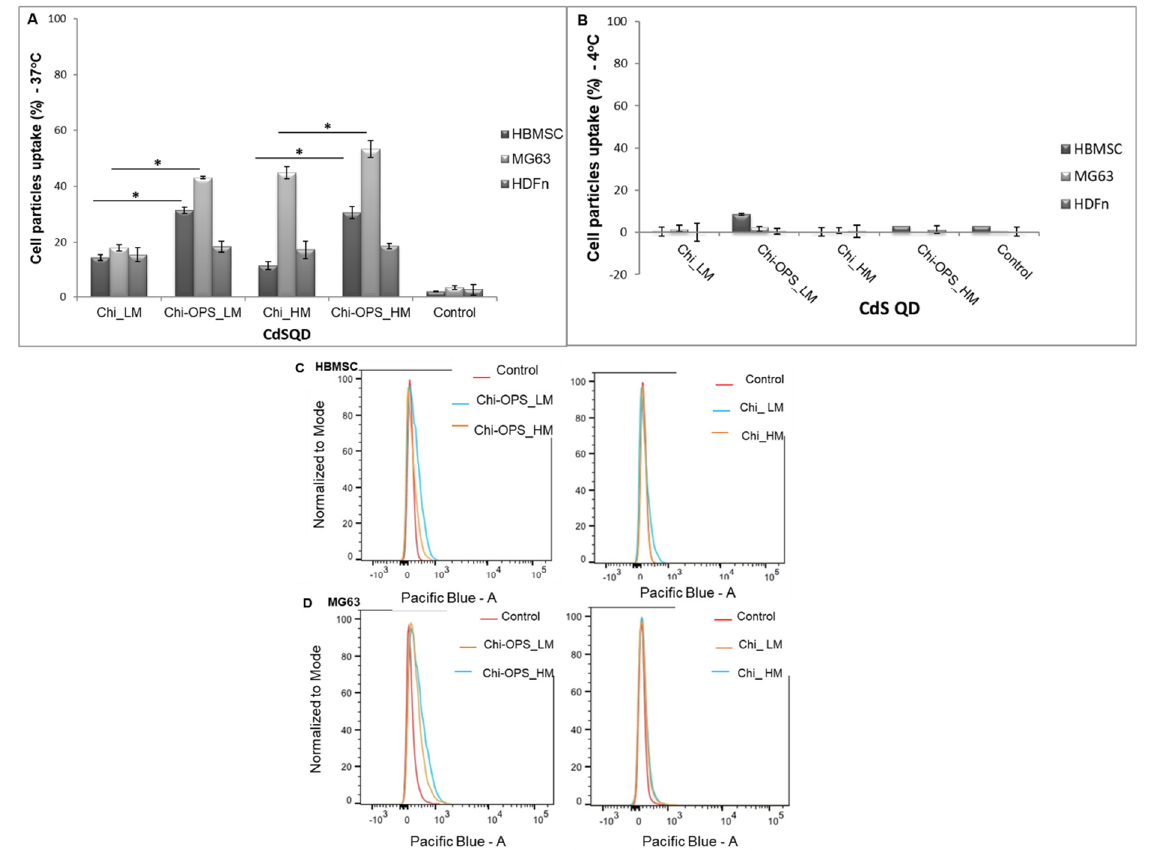
Figure 6. FACS evaluation of QD conjugated nanoparticles on HBMSC, MG63 and HDFn) cell uptake response. The results were normalized based on the untreated control (X-mean of TCPS). ( A ) Cell culture at 37 °C for the incubation period of time, to allow cellular uptake. ( B ) Cell culture at 4 °C for the incubation period of time, to block cellular uptake. Histograms of quantitative flow cytometry results with HBMSC ( C ) and MG63 cells ( D ). Statistical analysis, * p < 0.05.